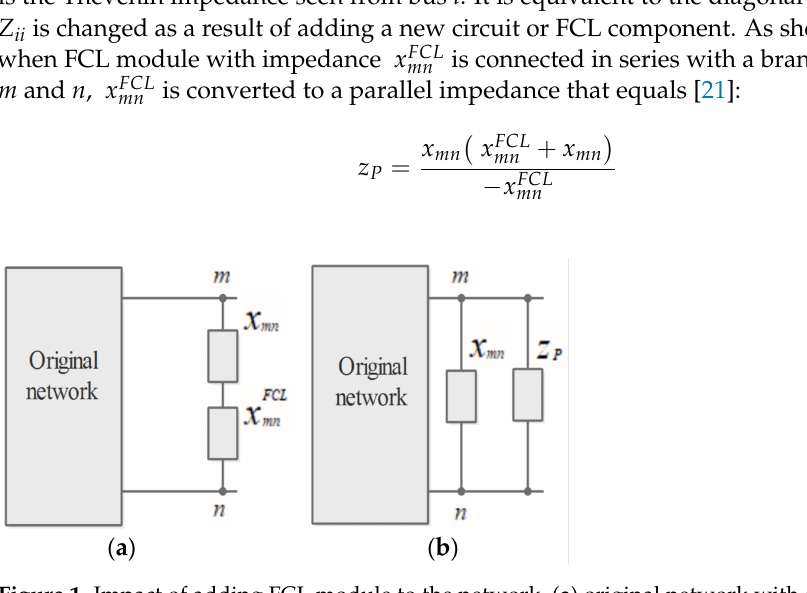
Figure 1. Impact of adding FCL module to the network, ( a ) original network with added series FCL, ( b ) original network with equivalent